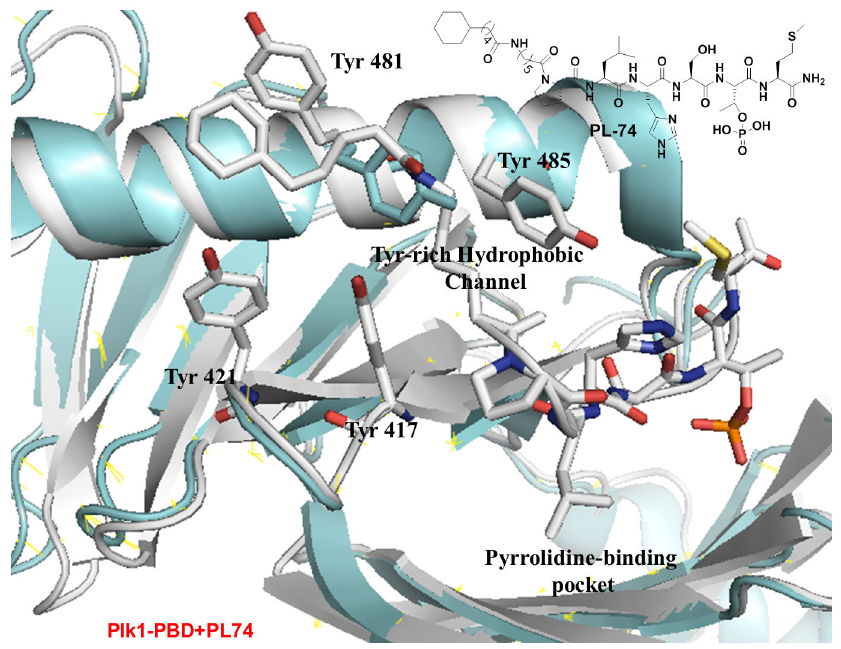
Figure 5. Crystal structures of Plk1 PBD in complex with PL-74. The overlay of the crystal structures of the Plk1 PBD-bound PL-74 (white) over the previously reported unligated Plk1 PBD (cyan) revealed that the N- terminal cyclohexyl moiety of PL-74 bound deeply into the Tyr-rich hydrophobic